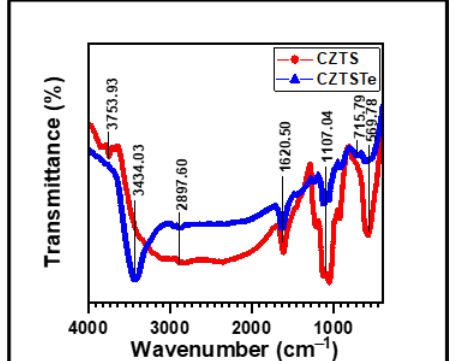
Figure 2. FTIR spectrum of CZTS and CZTSTe nanomaterials.